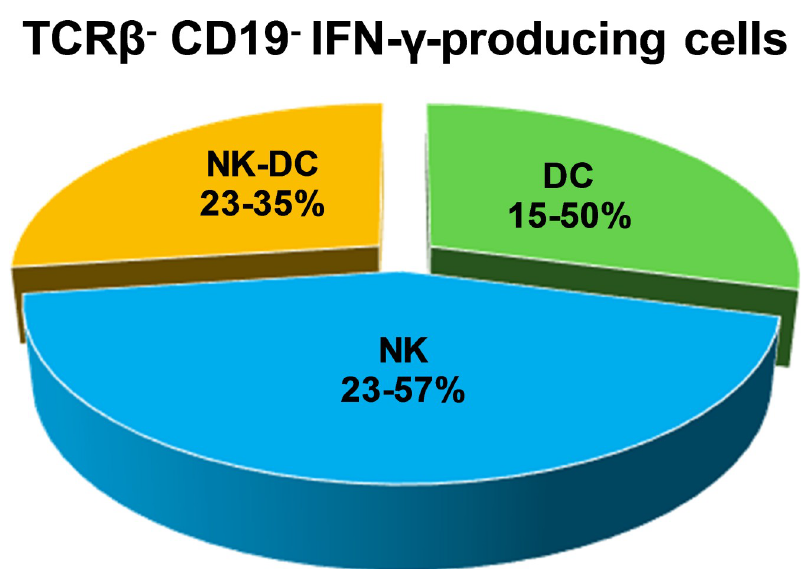
Fig 2. Multiple myeloid subpopulations produce IFN- γ during innate immune response against Ft LVS infection. C57BL/6 mice were infected with 10 5 LVS. After four days, single cell suspensions of splenocytes from LVS-infected were prepared and analyzed by flow cytometry. After exclusion of fragments, aggregates, and dead cells, IFN- γ producing non-B non-T cells were quantified according to surface markers coupled with ICS. DC were identified as CD11c + MHCII + NK1.1 - B220 - CD11b + Gr1 - . NK cells were identified as NK1.1 + CD11c - MHCII - . NK-DC cells were identified as NK1.1 + CD11c + MHCII +/- CD11b +/- Gr1 - . The relative proportion of IFN- γ production by each cell type is shown using a pie chart. Data represent the range of proportions found in five independent experiments of similar design and outcome.